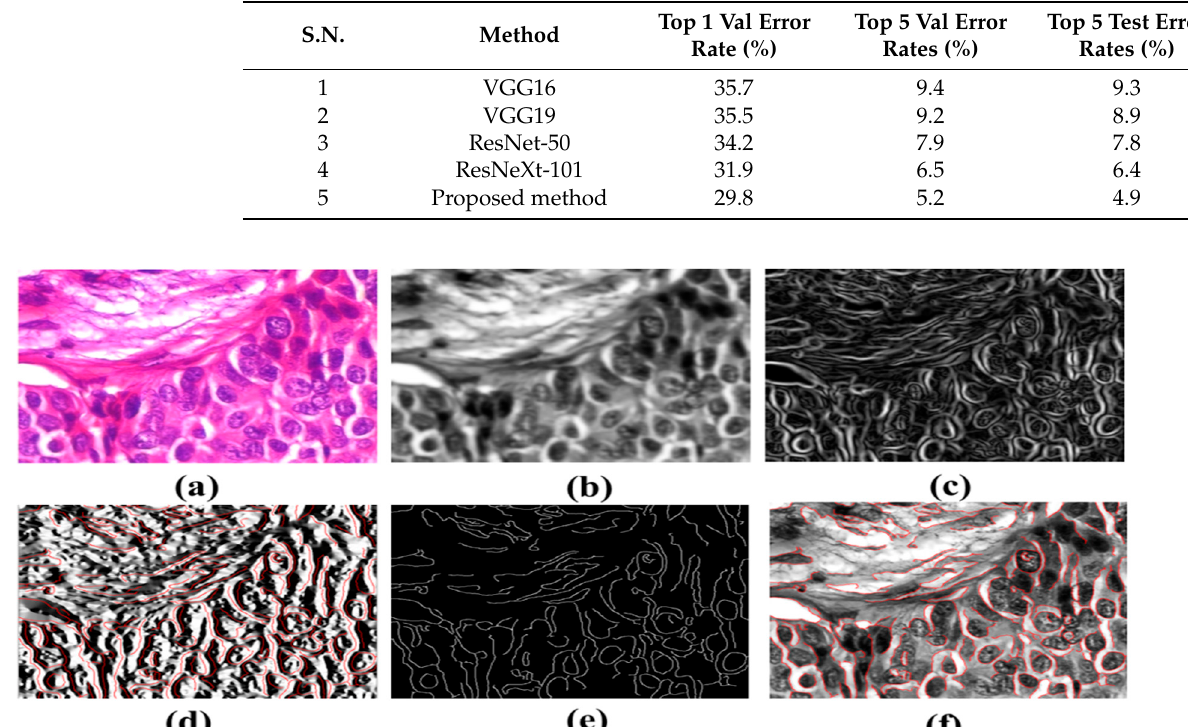
Table 4. The Proposed Model’s Evolution Metrics.